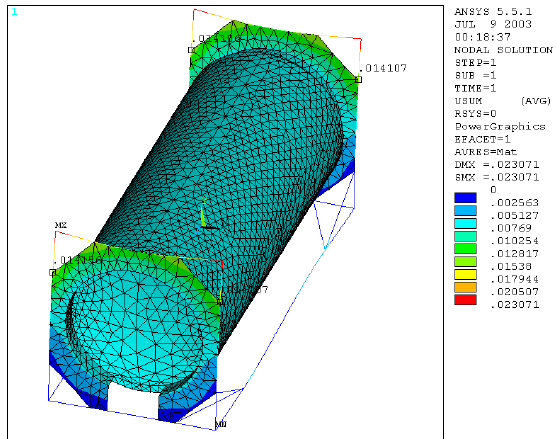
Figure 16. Nodal displacements.